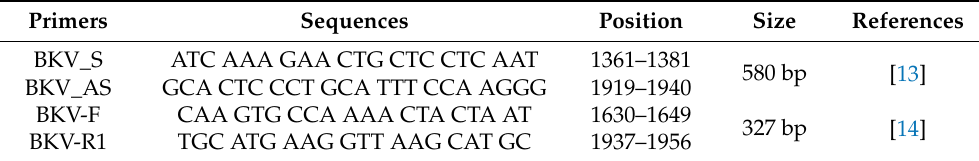
Table 1. Primer sequences used in our